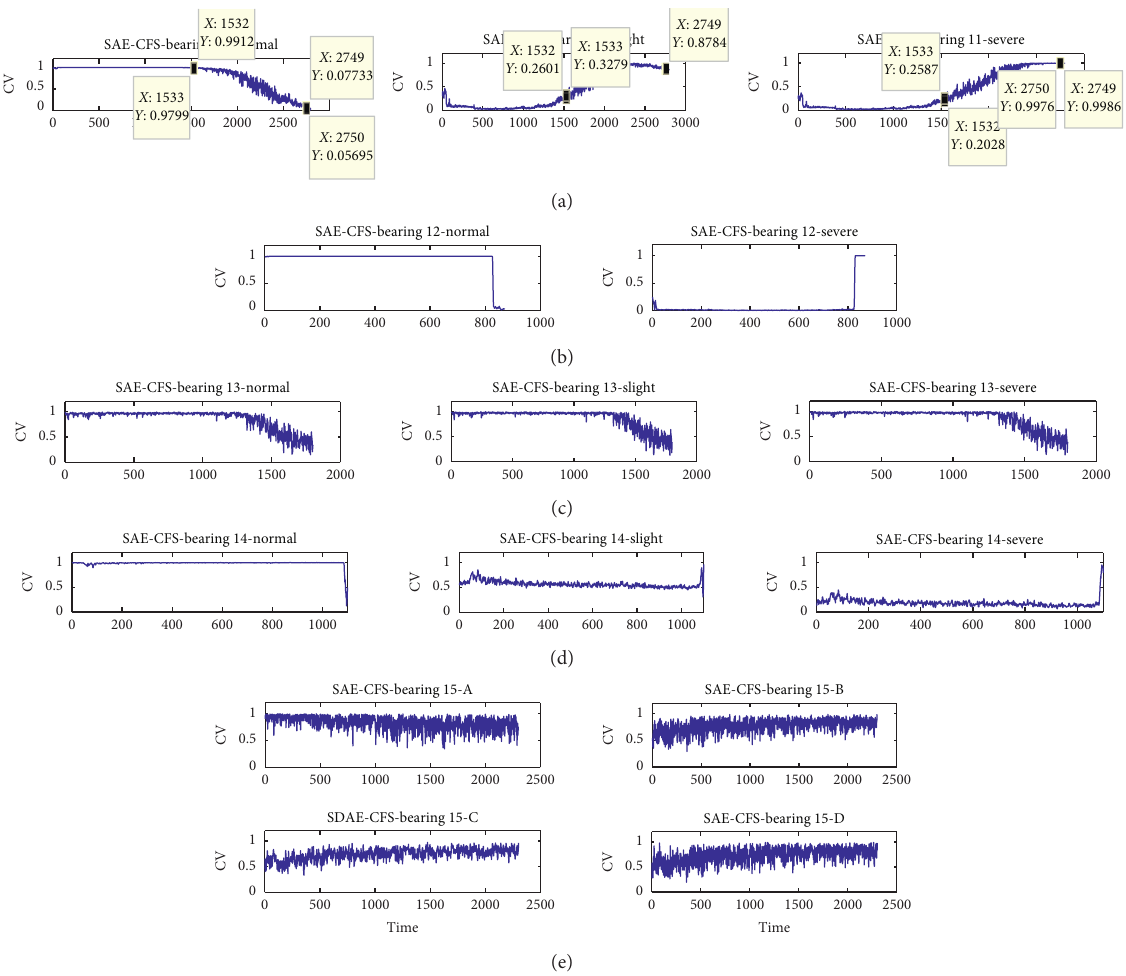
Figure 15: CVs for bearings 11–15 by using the SAE-CFS under various conditions such as “Normal,” “Slight,” and “Severe.”